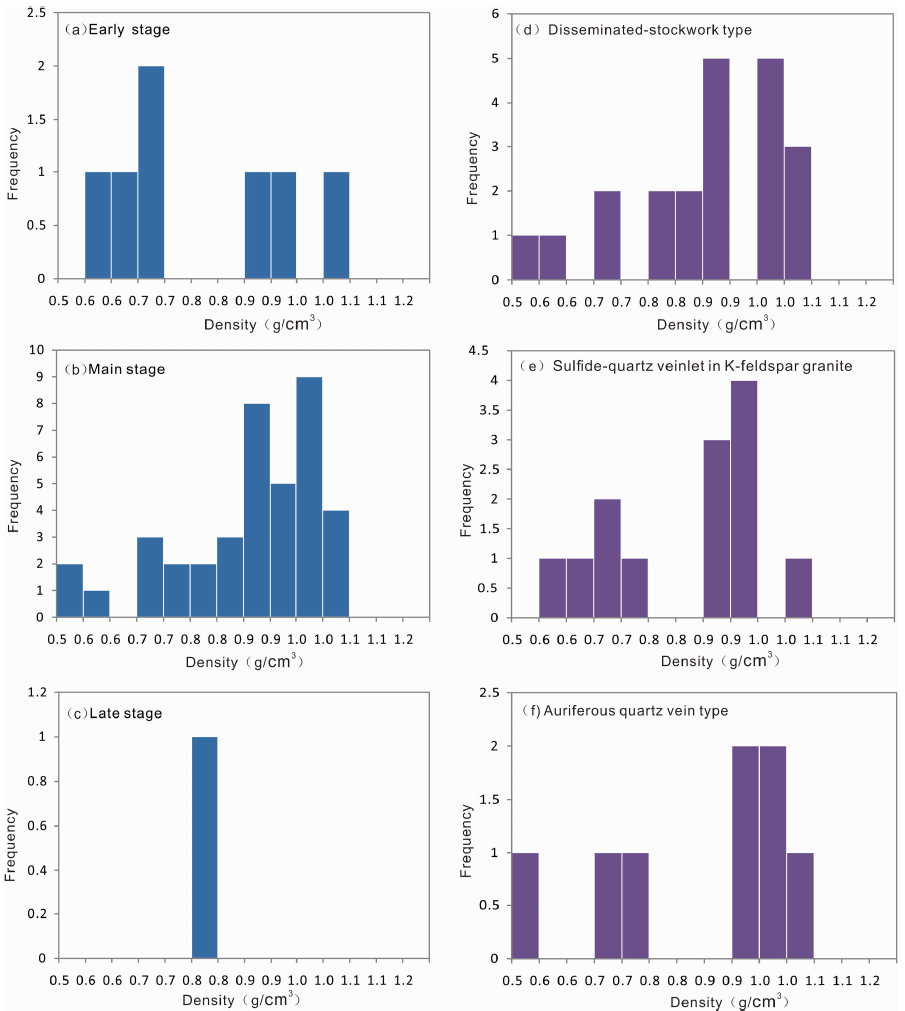
Figure 12. Histograms of the density of type 1 fluid inclusions: The range of inclusion density is wide in different stages or in different mineralization